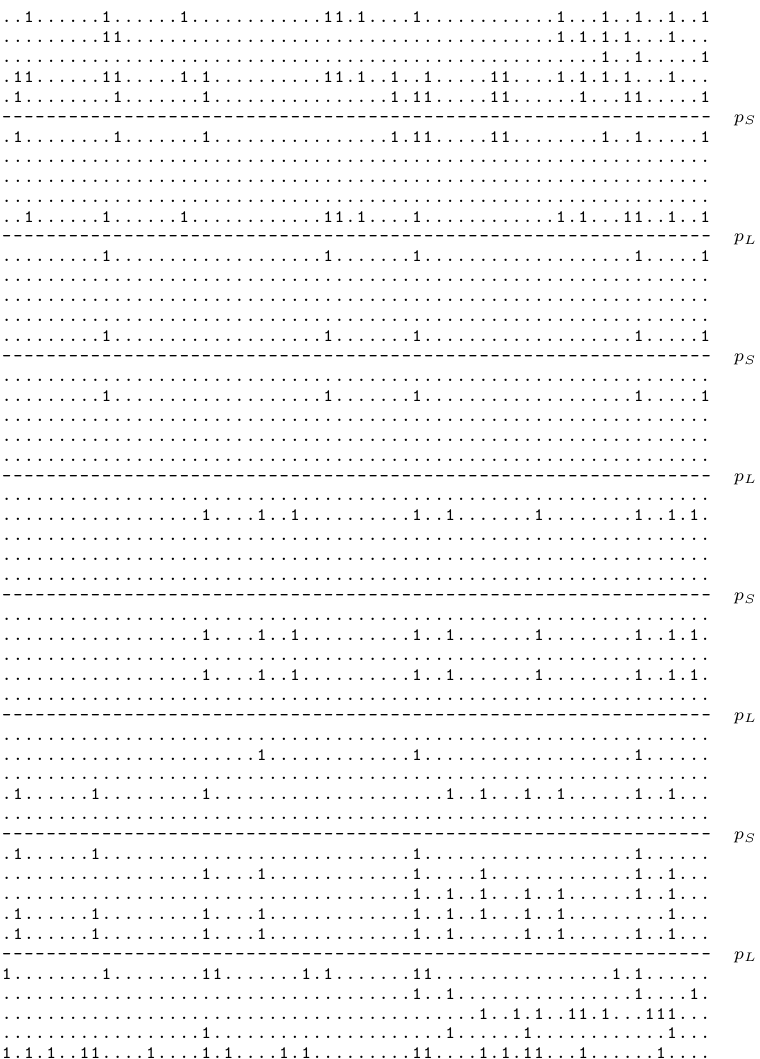
Figure 11: 5-round linear trail with 78 [21, 5, 9, 11, 30] active Sboxes and correlation 92 [21, 5, 18, 18,